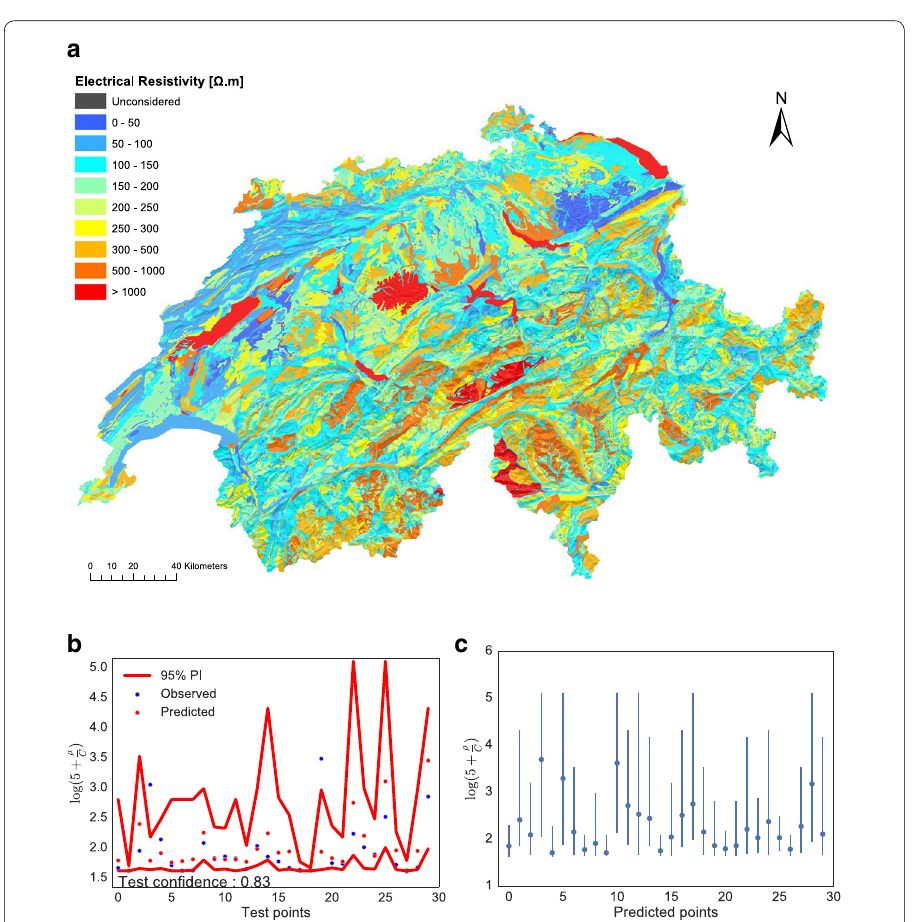
Fig. 11 Electrical resistivity map as estimated in the study with visualization of PIs (with 95% confidence) both in the test set and for new points. a Electrical resistivity ( ρ ) map; b PIs in the test set for the label variable ρ used ( log ( 5 C ) and not ρ ) while training the RF model; c PIs for 30 random unknown points for the same + label